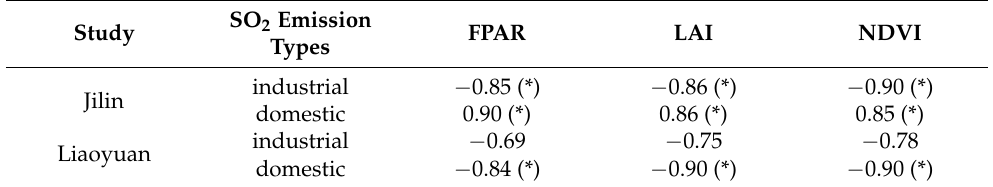
Table 9. Relationship between domestic, industrial SO 2 emissions and vegetation characteristic values in 2015–2020.